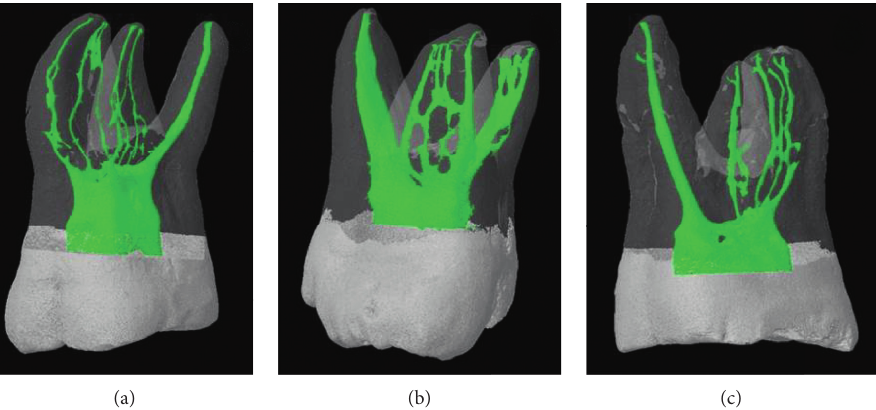
Figure 3: Burmese maxillary first molars with supplemental root canal configurations. (a) Mesiobuccal root shows Vertucci’s type VIII canal, while distobuccal and palatal roots reveal an additional canal type (3-2) and Vertucci’s type I canal, respectively. Sheet complete isthmus is connecting two additional mesiobuccal canals at the apical region of the mesiobuccal root, and tube complete isthmus is communicating between canals in the distobuccal root at all thirds. (b) Mesiobuccal root shows an additional canal type (4-4), while the distobuccal and palatal roots reveal an additional canal type (1–3) and Vertucci’s type I canal, respectively. Sheet complete type isthmus is connecting four mesiobuccal canals at the coronal, middle, and apical regions of mesiobuccal root. (c) Mesiobuccal root shows Vertucci’s type VIII canal with lateral canals at the apical third and sheet complete isthmus at the middle third. Both distobuccal and palatal roots reveal Vertucci’s type I canal with a lateral canal at the apical